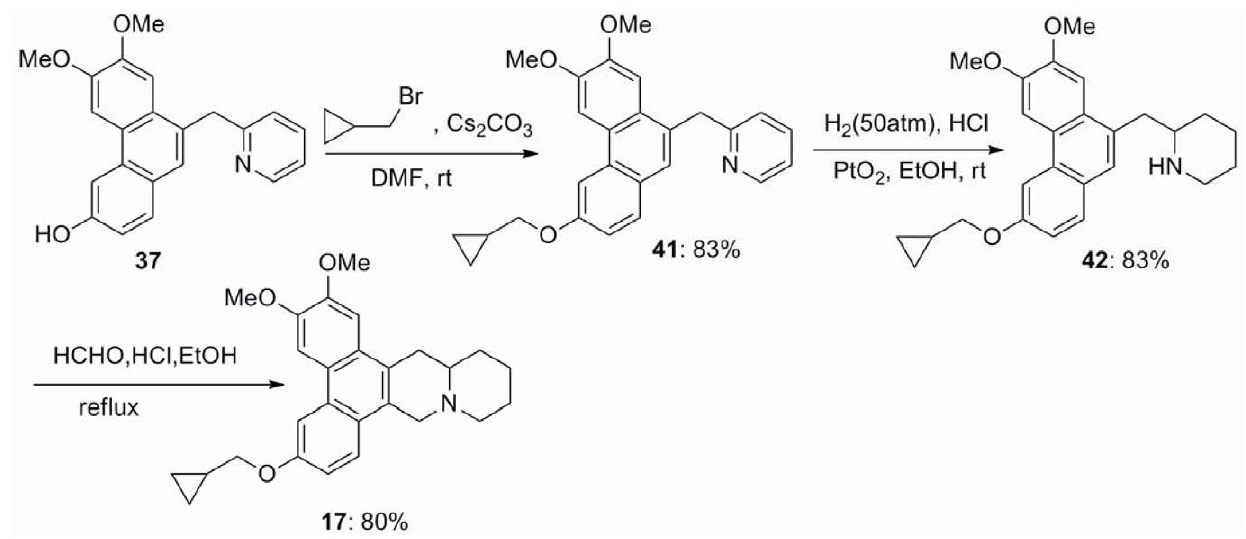
Figure 5. Synthesis of compound 17.